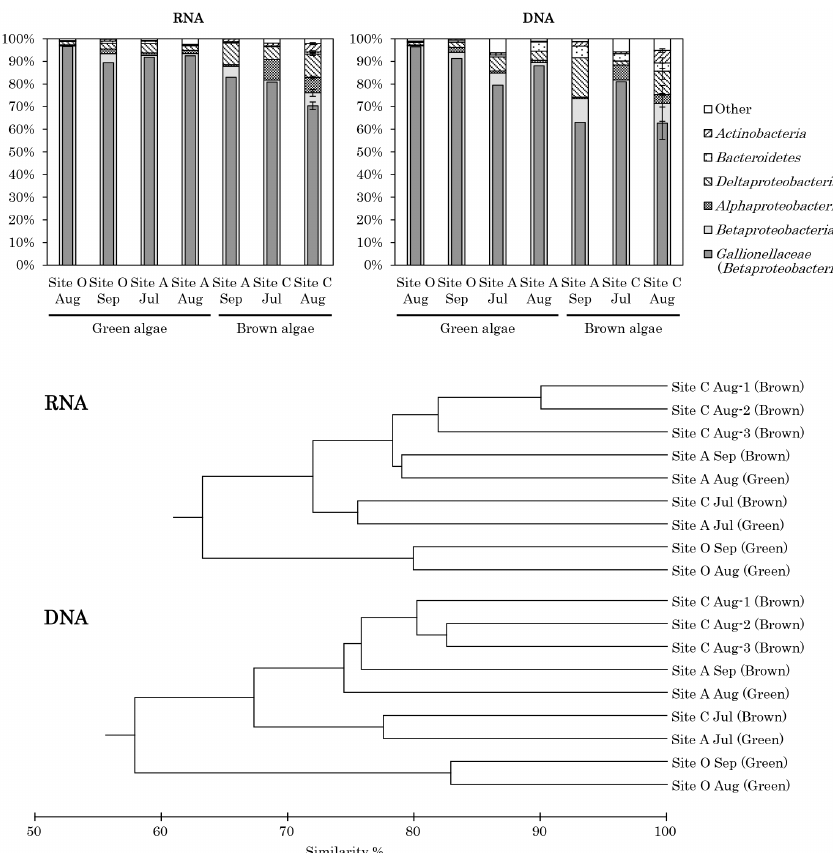
Figure 7. Bacterial community compositions obtained from algal samples detected by 16S rRNA gene-targeted amplicon pyrosequencing (above) and dendrograms indicating similarities of RNA and DNA compositions (below). Calculations of the bacterial populations were based on the total numbers of OTUs associated with phylotypes of sequenced representatives at the phylum level, or class level for Proteobacteria. Percentages of Gallionellaceae ( Betaproteobacteria ) were also shown. ( n = 1; Site C Aug, n = 3, error bars indicate